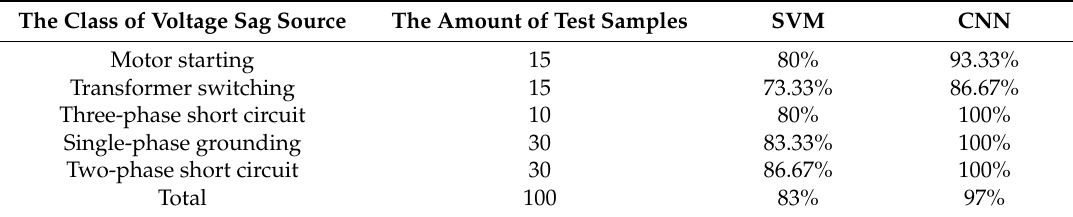
Table 5. Accuracy of different voltage sag source identification